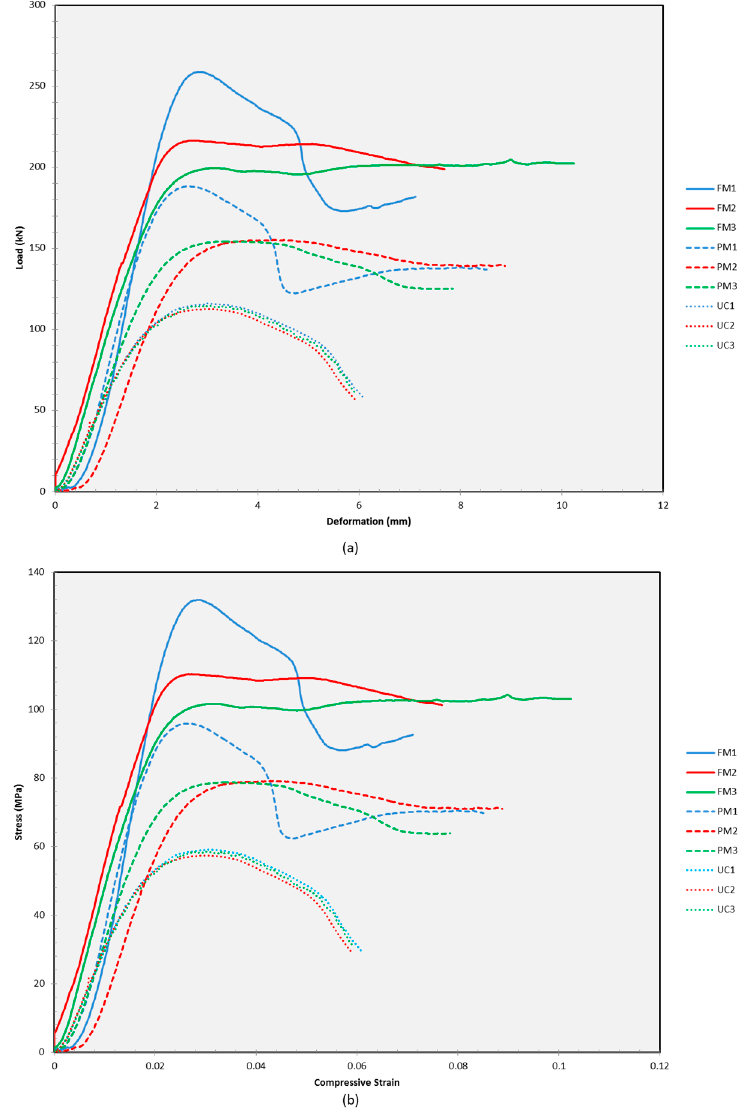
Figure 8. ( a ) Load versus deformation curve for all samples. ( b ) Stress versus strain curve for all samples.